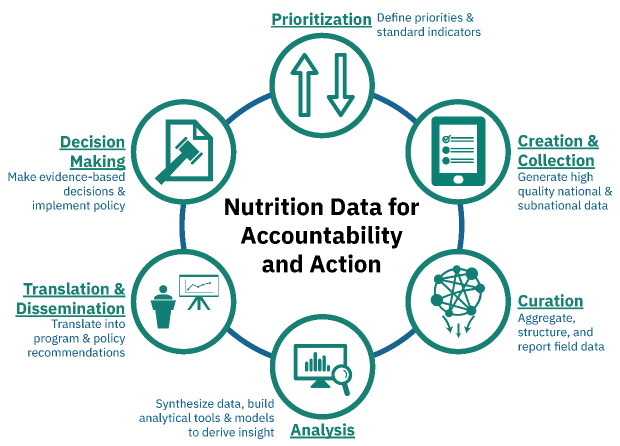
Nutrition Data Value Chain.Adapted from
Piwoz
et al., 2019.